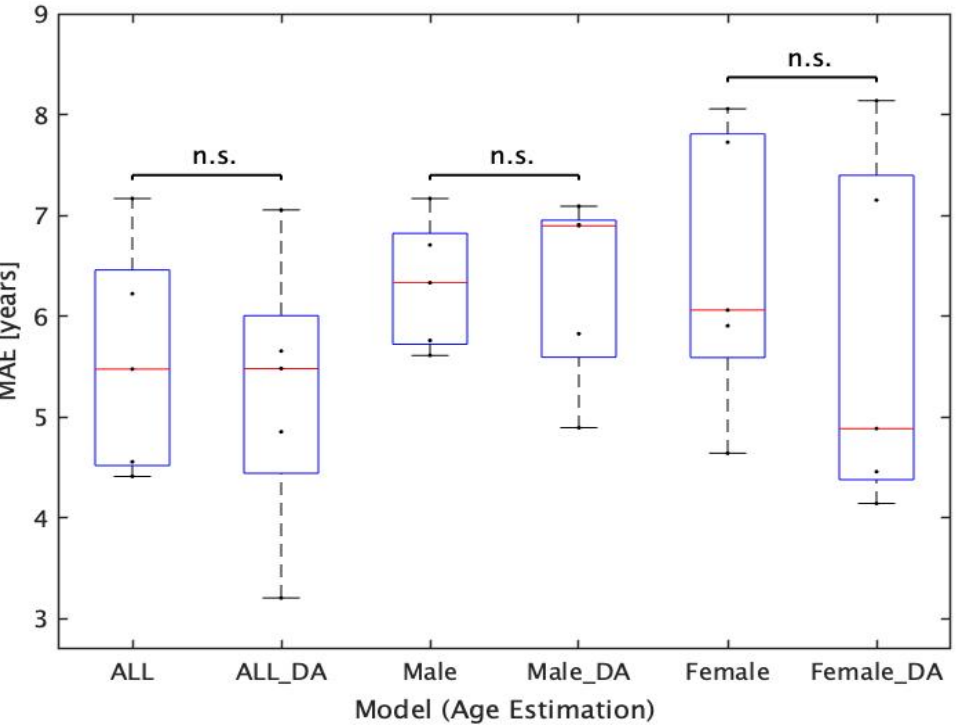
Figure 7. Results for mean absolute error (MAE). (DA: Data Augmentation).